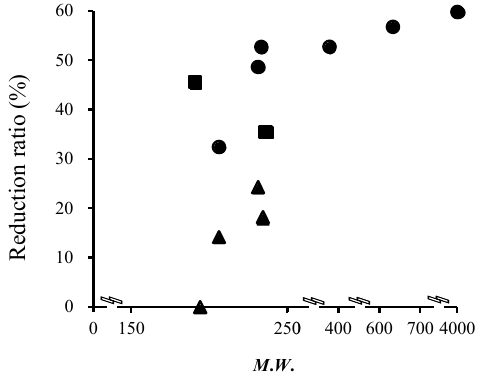
Figure 4. Relationship between the reduction ratio of skin permeation by hair follicle plugging and the molecular weight of the chemicals. : ionized form (acidic or basic) chemicals; : non-ionized form (acidic or basic) chemicals; : neutral chemicals.